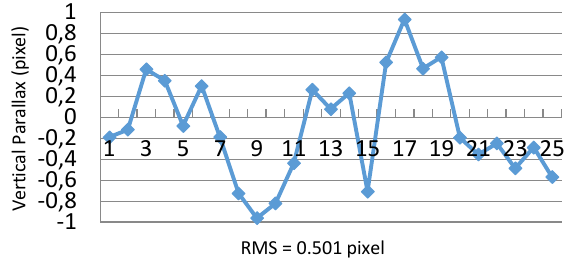
Figure 5. Distance between conjugate points and the quasi- epipolar line of 1st stereo image pair